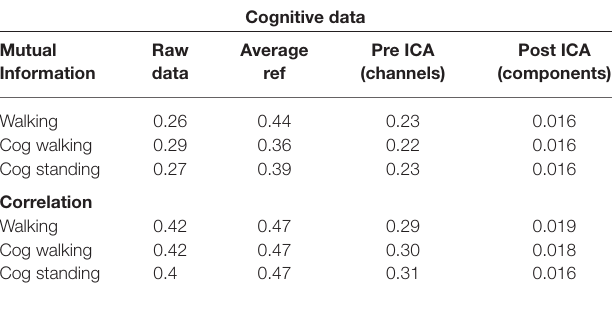
TABLE 2 | Mutual information and correlation at various stages of analysis for the EEG data for just walking, walking with a cognitive task, and standing with a cognitive